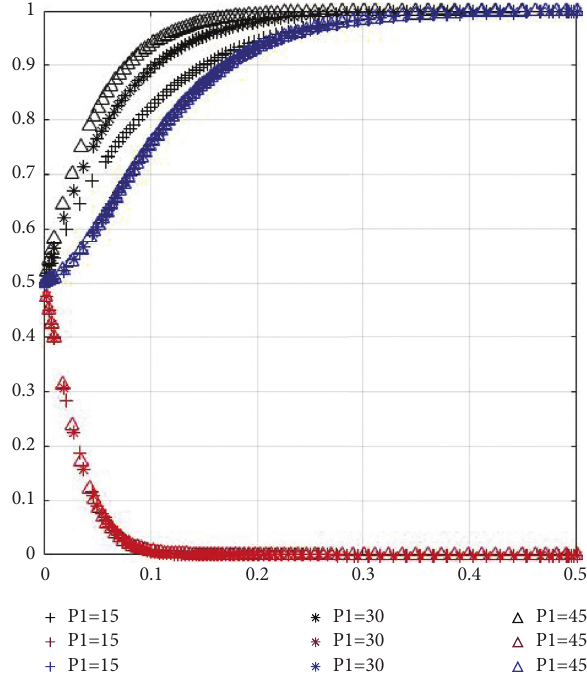
Figure 6: Participation willingness y remains unchanged, while x and z change simultaneously ( x � z � 0.1 ⟶ x � z � 0.9).